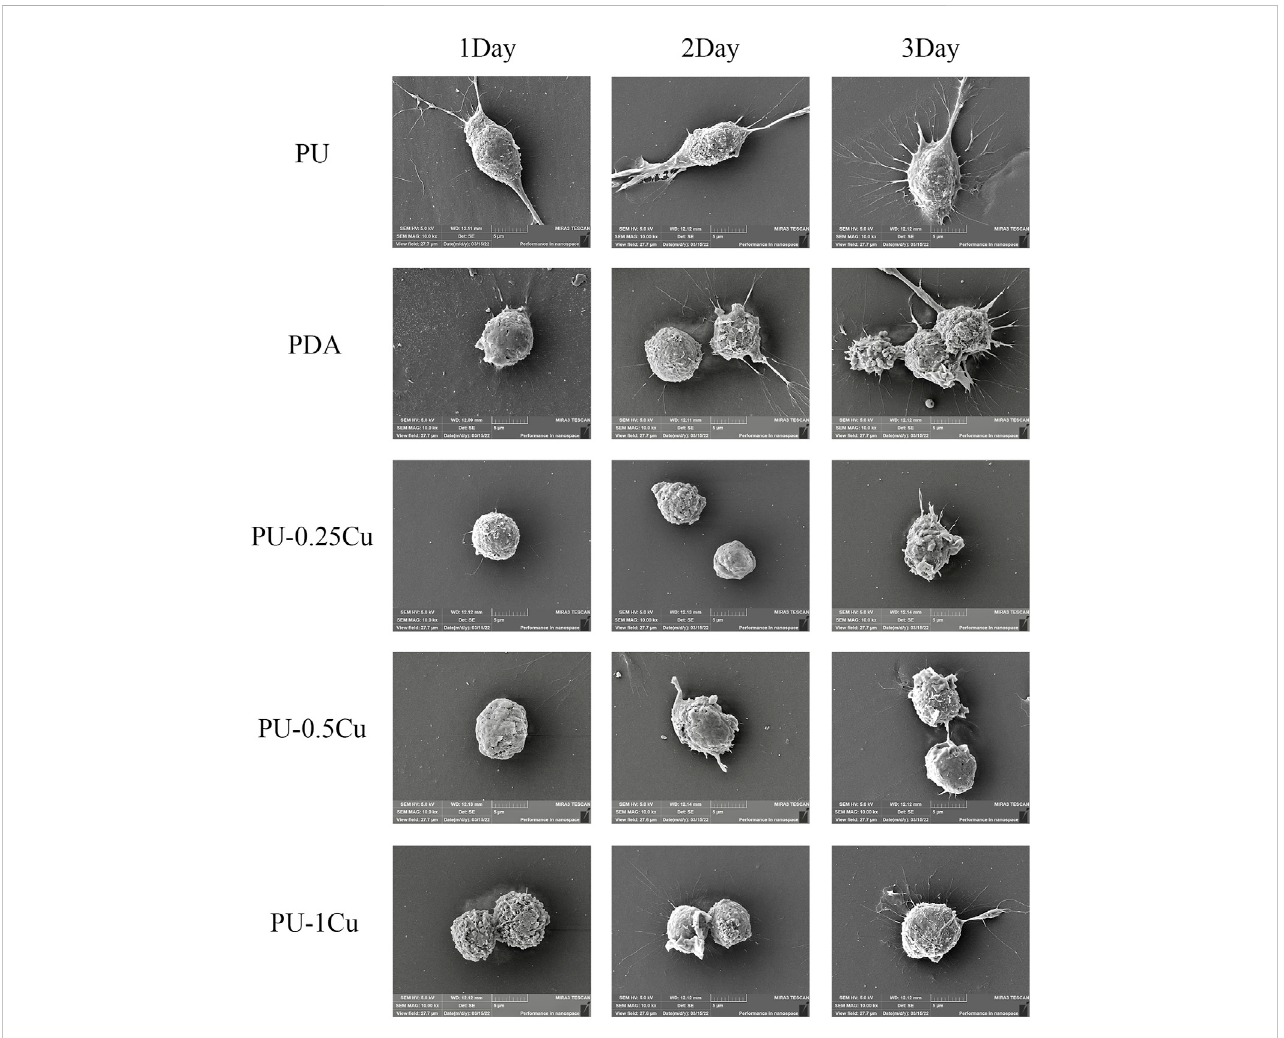
SEM images of RAW264.7 on the surface of